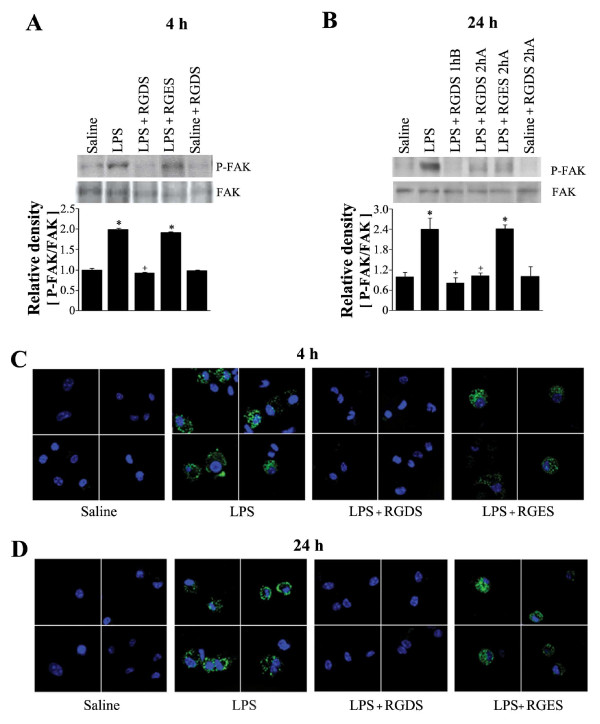
Effects of RGDS on FAK phosphorylation in lung tissue (A, B), and fibrinogen binding activity in alveolar macrophages (C, D). Where indicated, mice were administered RGDS or RGES (5 mg/kg, i.p.) once 1 h before LPS treatment and sacrificed 4 h post-LPS. Mice were also administered this peptide (5 mg/kg, i.p.) once 1 h before or 2 h after LPS and sacrificed 24 h post-LPS. (A, B) Western blotting with each anti-specific (phospho) FAK Ab was performed on lung tissue homogenates. Relative values for phosphorylated FAK versus FAK are indicated below the gel. Values represent means ± SEM of 5 mice per group. *Significantly different from saline treated controls, p < 0.05; +significantly different from animals treated with LPS only, p < 0.05. (C, D) Alveolar macrophages were incubated with fibrinogen conjugated to Alexafluor-488 for 20 min. After exposure to fibrinogen for 20 min, cells were fixed and then analyzed by confocal fluorescence microscopy. The results are representative results obtained from 5 mice per group.